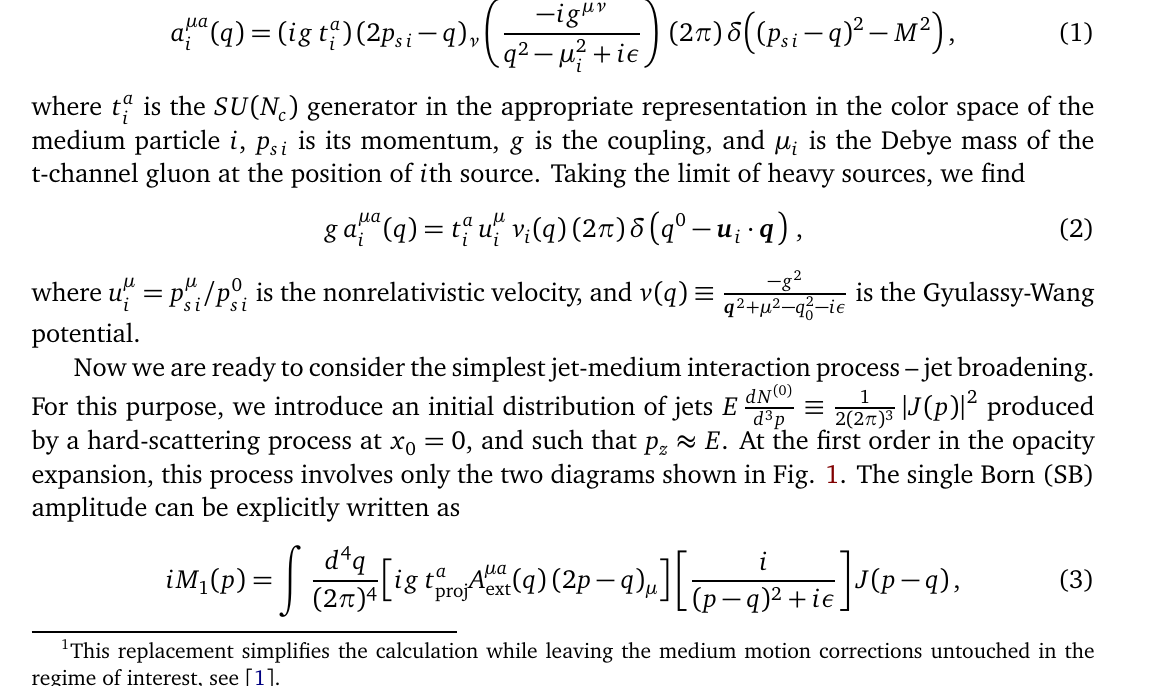
Figure 1: The single-Born (SB) amplitude M M (right) for transverse-momentum broadening in an external 2